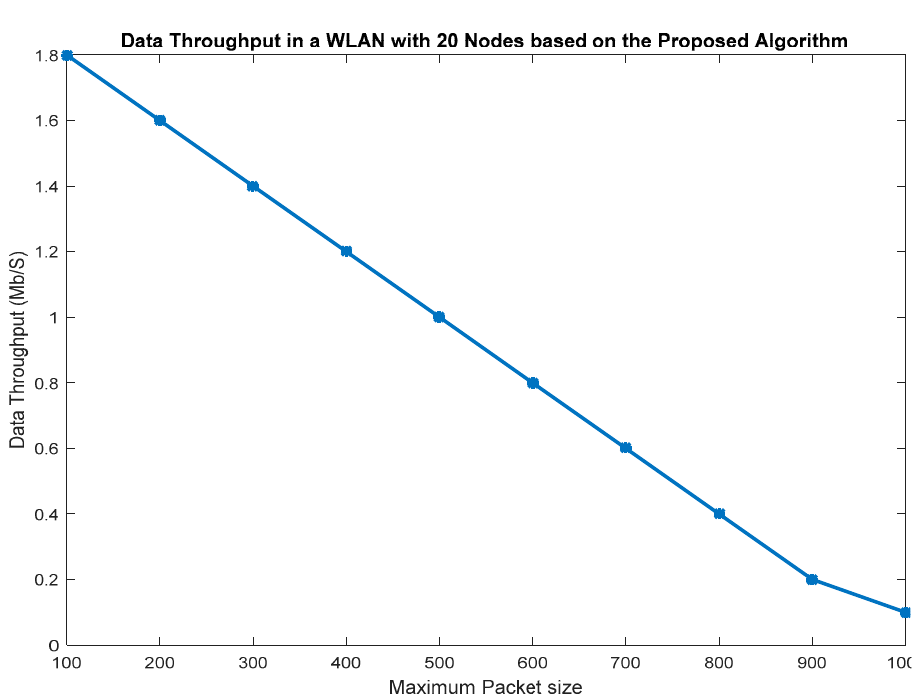
Figure 4. Data throughput versus of the maximum packet size.